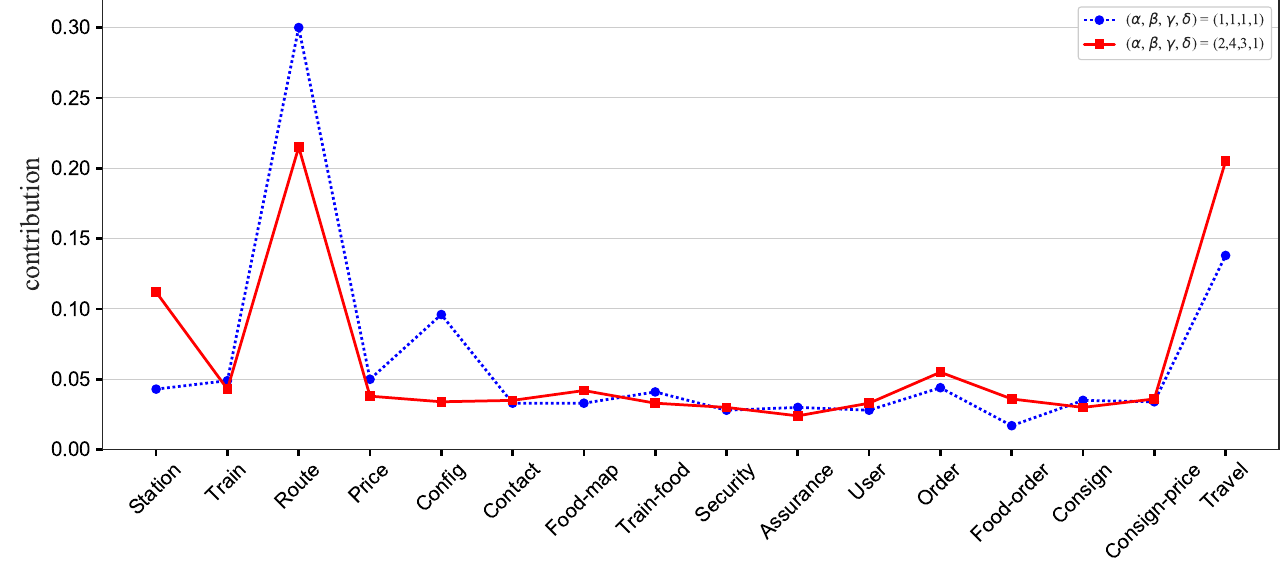
Figure 11. The database contributions to business scenarios in TrainTicket